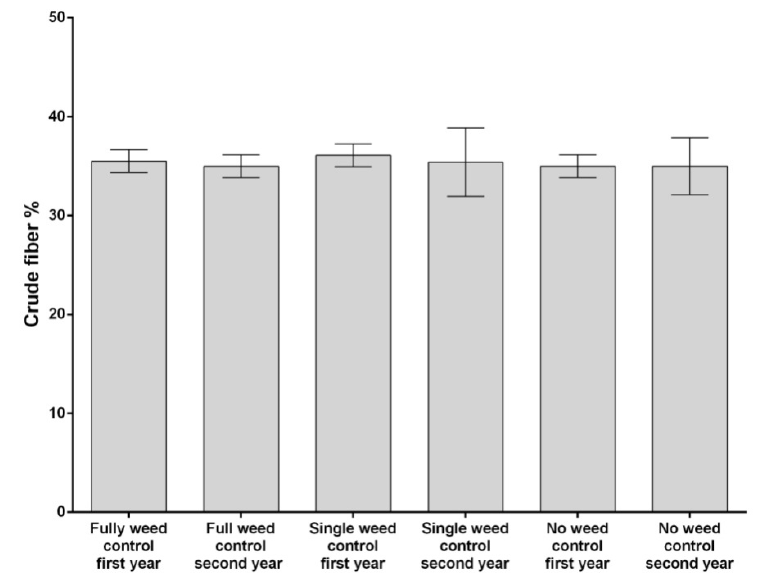
Figure 2. Mean comparison by year of the effect of weed management on crude fiber. All measurements were performed in triplicate. Data are shown as the mean ± standard deviation. There were no significant differences.